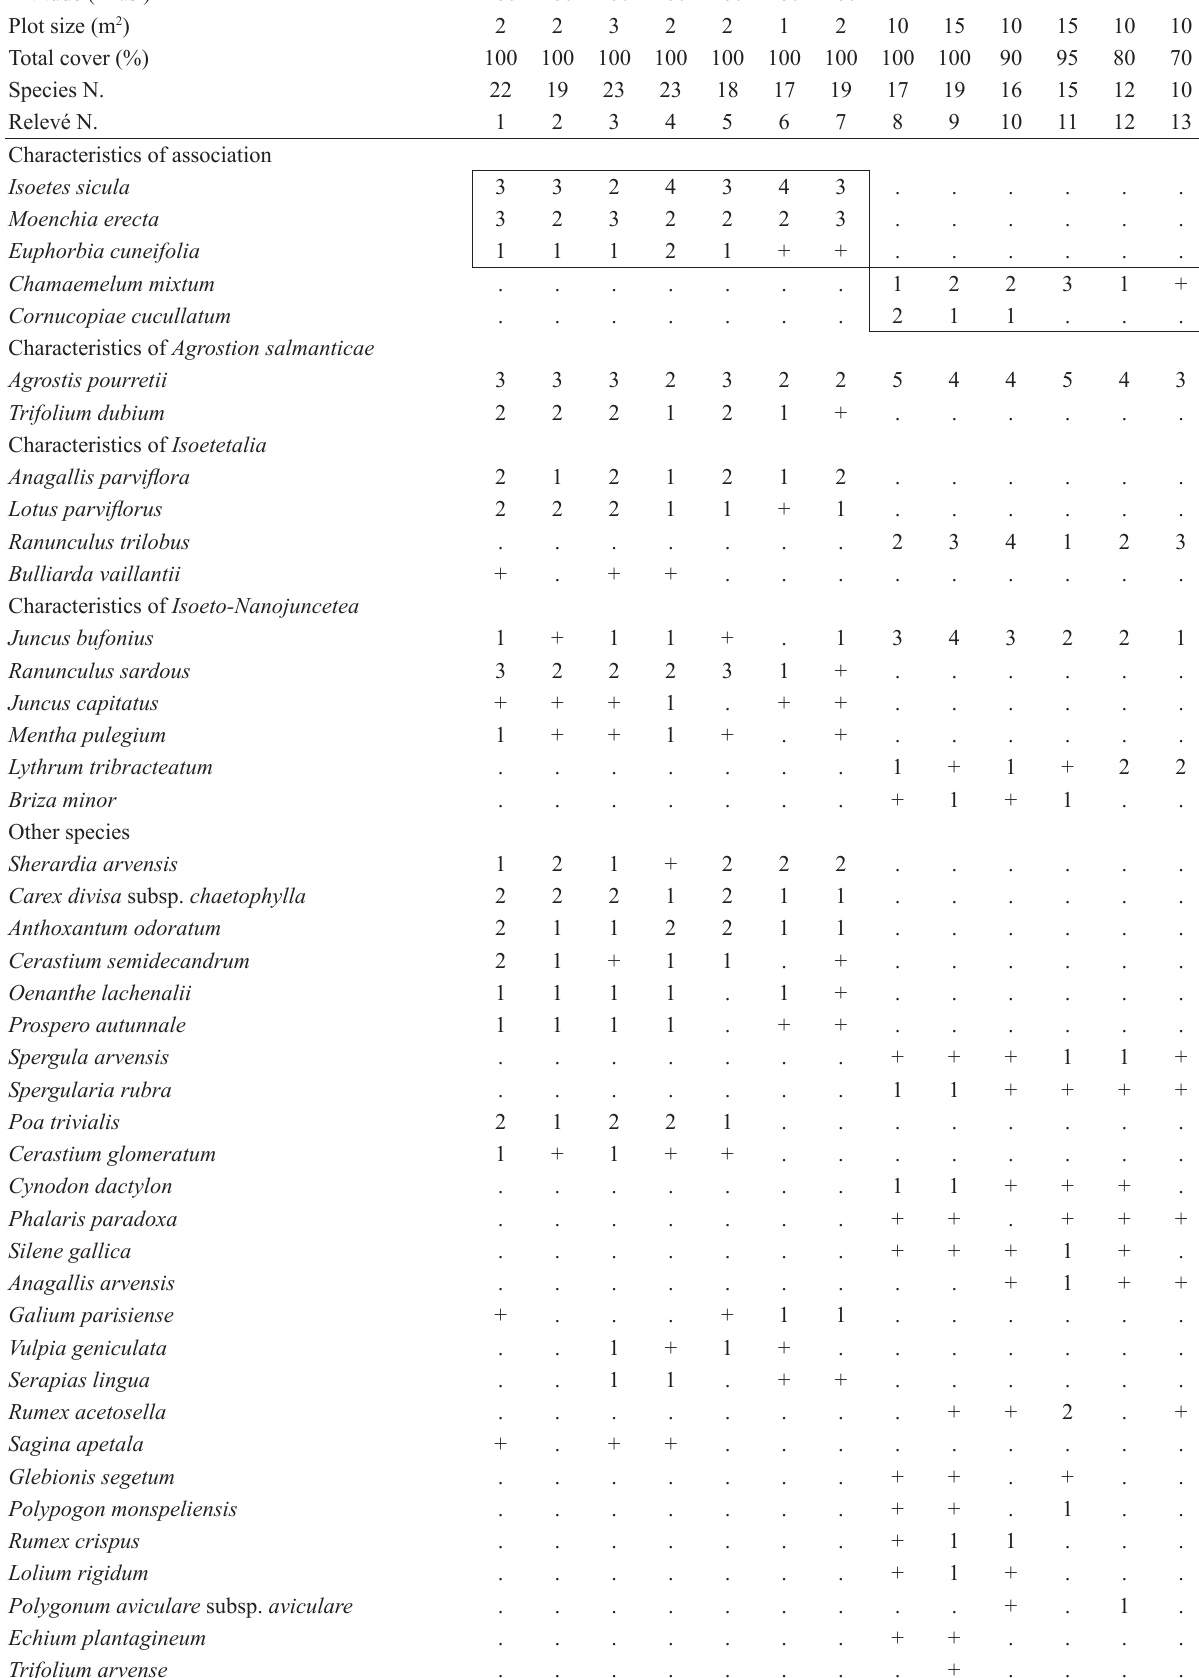
Polygonum aviculare subsp.